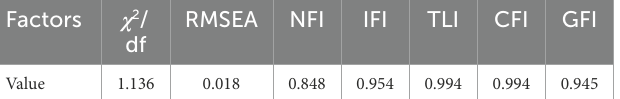
TABLE 5 Model fit indices. TABLE 6 The regression weights of casual